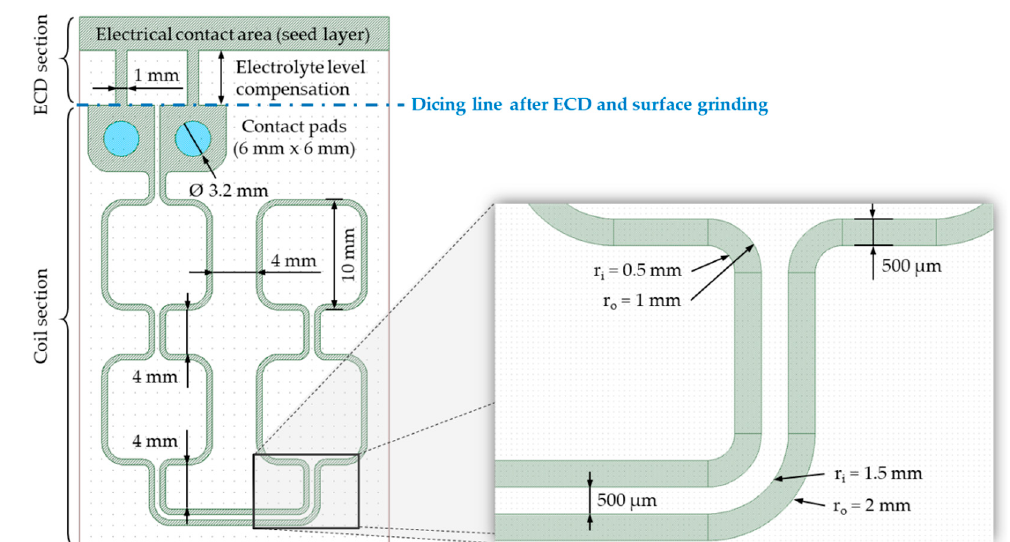
Figure 6. Micro coil design with the ECD section as well as the coil section.